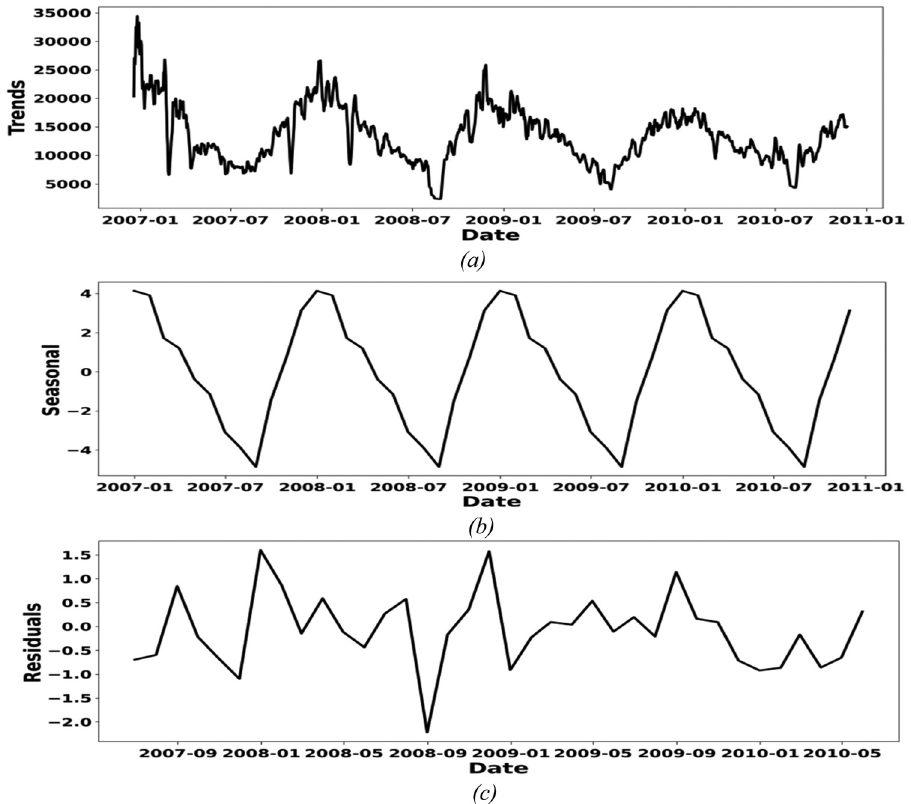
Figure 3: Household electricity consumption decomposition based on monthly granulate. ( a ) Trend, ( b ) seasonality, and ( c ) stationary ( residuals ) .